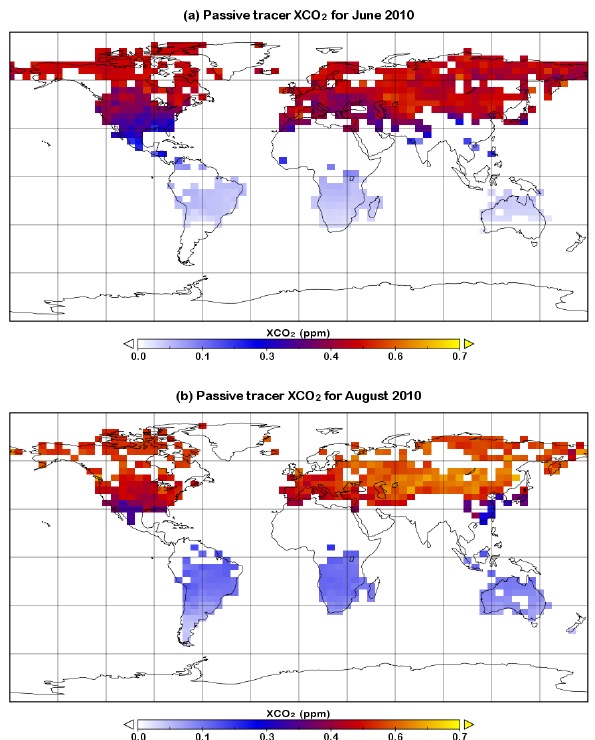
Figure 8. Monthly mean distribution of a passive tracer with a con- stant source equivalent to the CO 2 adjustment in the Arctic UTLS for March–August 2010. The tracer distribution was sampled at the GOSAT observation locations and times and vertically integrated, using the GOSAT averaging kernels, to produce XCO 2